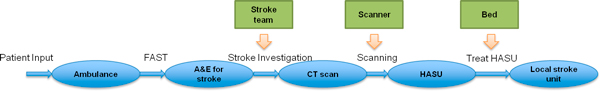
Simplified stroke clinical pathway.